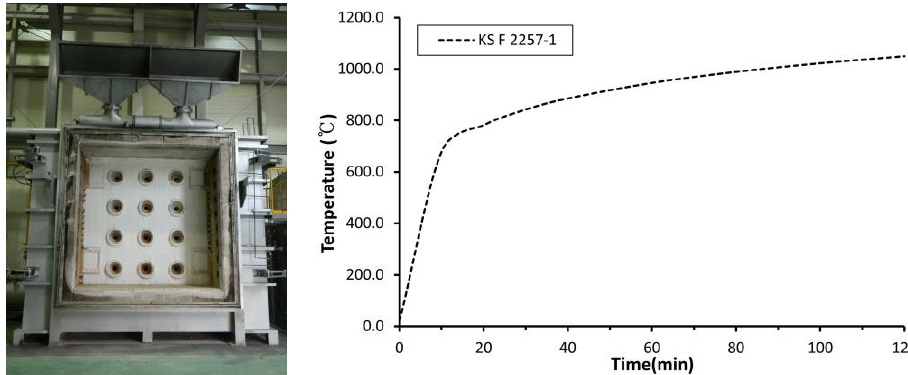
Figure 1. Vertical furnace and heating temperature according to the heating conditions of KS F 2257- 1.